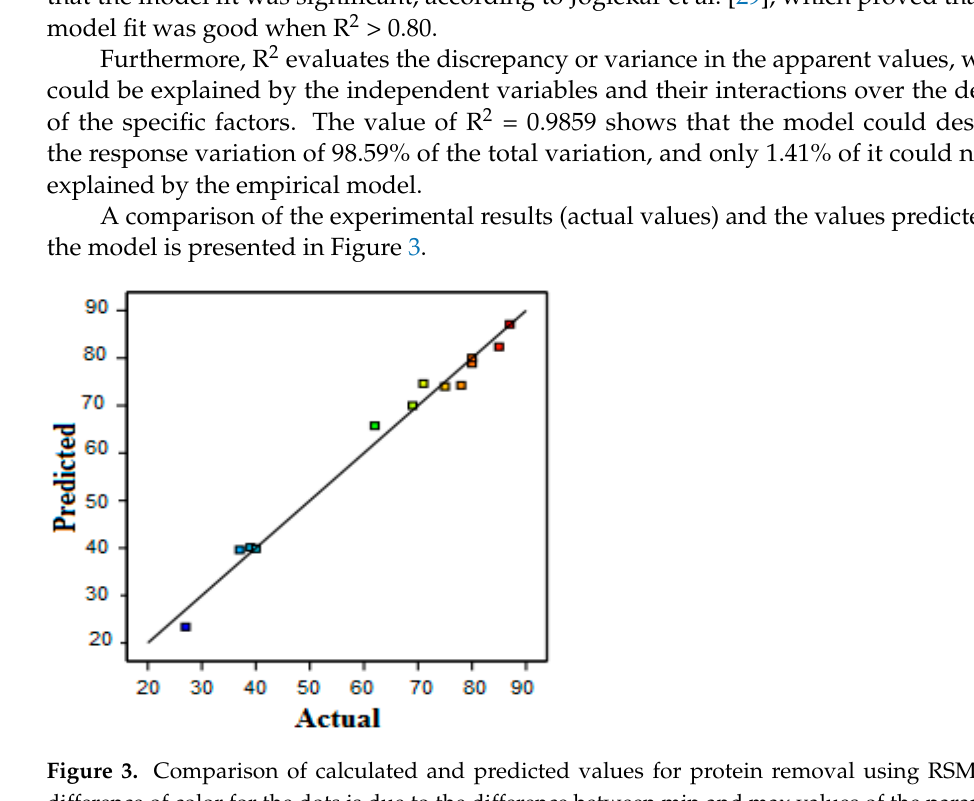
Table 4. Estimated coefficients for responses protein and permeate flux.